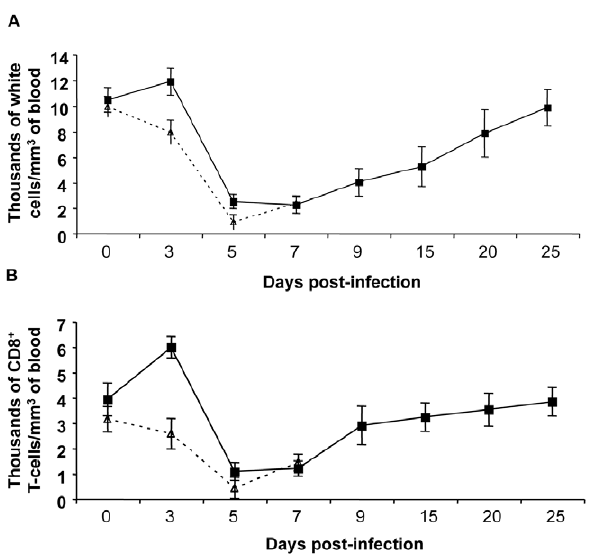
Figure 6. Surviving pigs show a delay in the viremia onset and clear the virus by day 25 post-infection. Pigs immunized with pCMV-UbsHAPQ, either twice (A) or four times (B) were infected with 10 4 UHA of the E75 isolate and blood samples were taken serially at days 3, 5, 7, 9, 12, 15, 20 and 25 to follow the viremia kinetics. Individual results are represented as the logarithm of HAU 50 /ml serum, while mean and standard deviation values are represented in both panels for the pCMV-immunized control group.